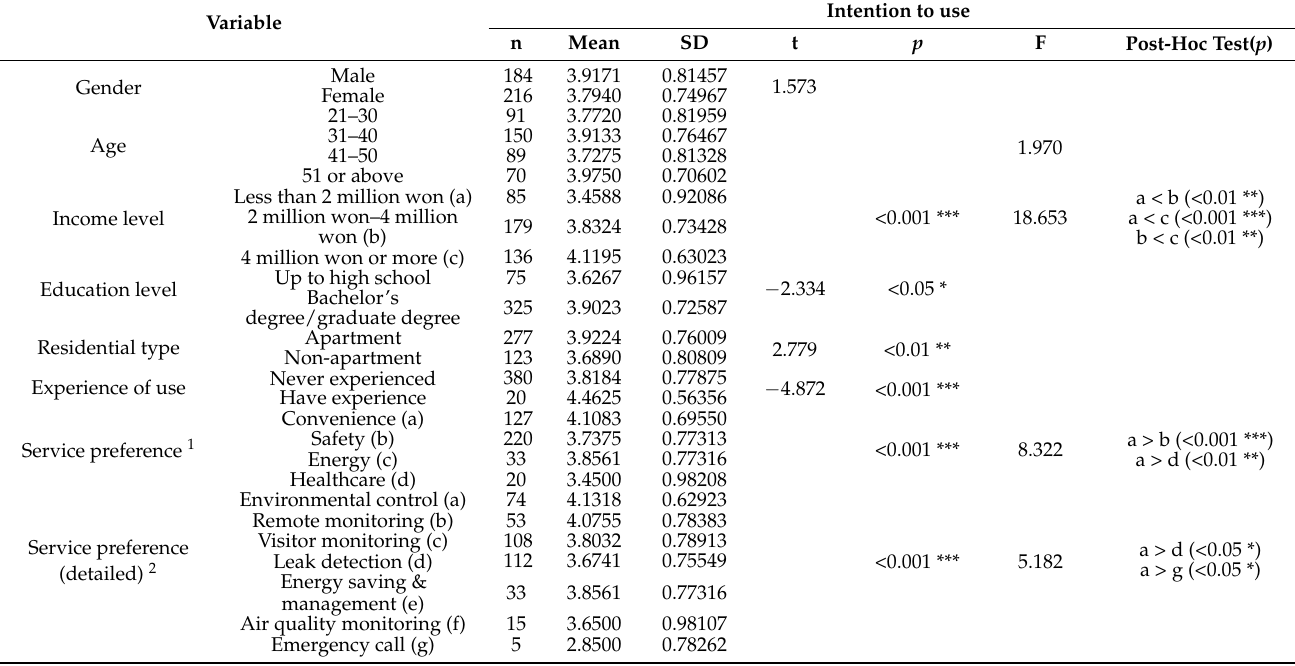
Table 5. T-test and ANOVA test results (* p < 0.05, ** p <0.01, *** p <